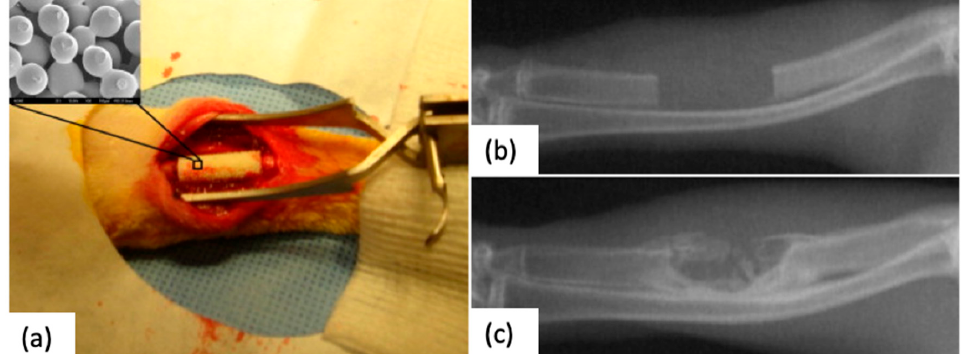
Figure 5. ( a ) Implantation of a sintered microsphere-based scaffold in a 15 mm induced ulna defect. ( b ) Appearance of the defect immediately after the surgical procedure, ( c ) radiograph on the defect site after 12-week post-operation with clearly new bone formation [43]. Figure reprinted from Acta